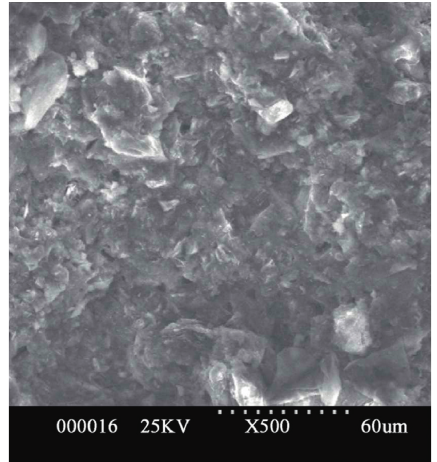
Figure 15: Micromorphology of PC.